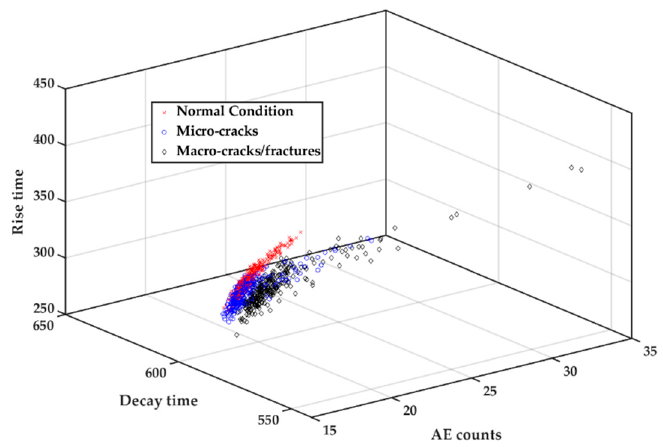
Figure 13. 3D plot of the feature space.